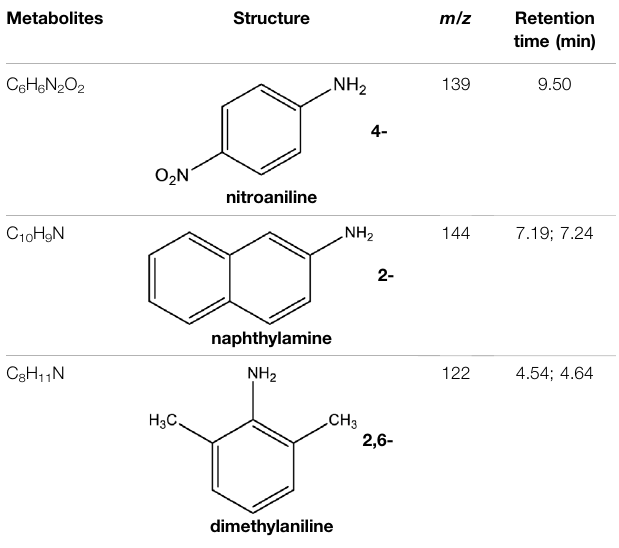
TABLE 2 | Degradation products of AB210 in samples collected from the tannery industry.